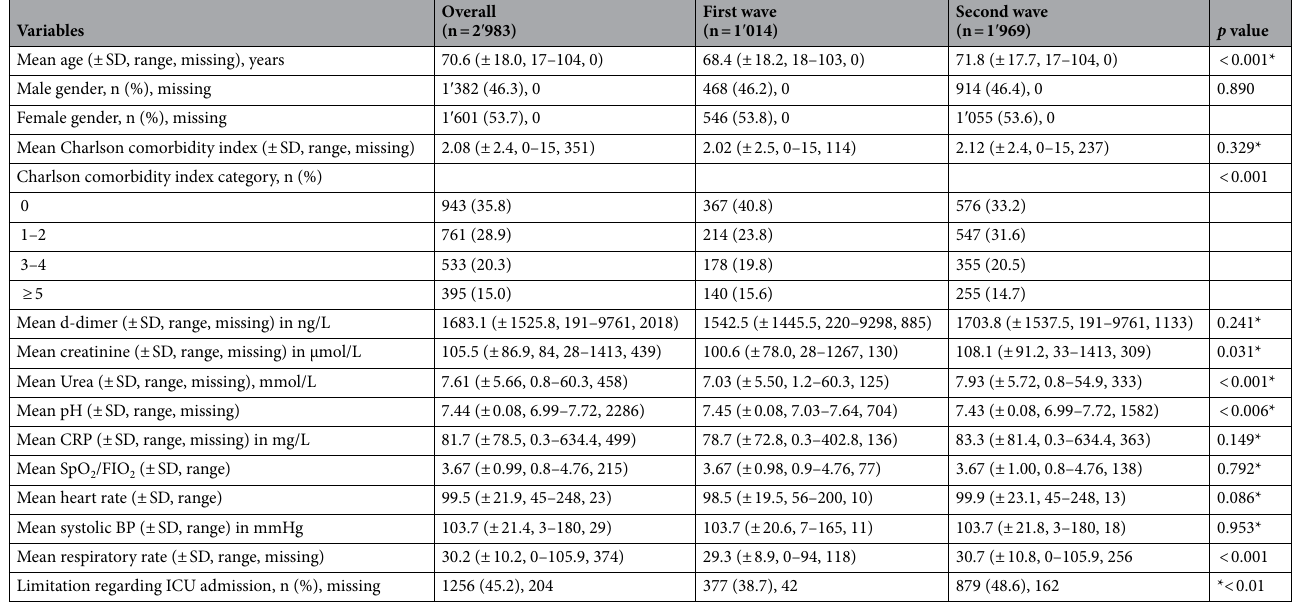
Table 1. Patient characteristics during the two successive COVID waves at HUG. *Student test for comparisons of continuous variables; **Chi-2 tests for comparisons of categorical variables.